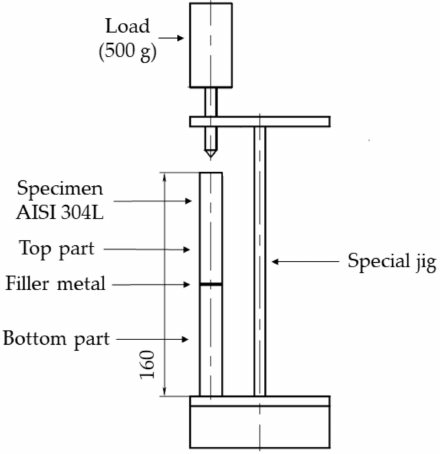
Figure 1. Scheme of the jig construction for